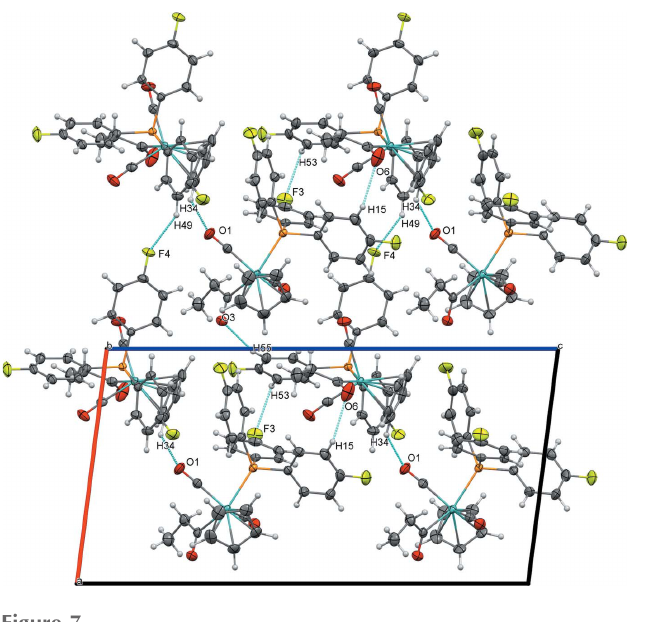
Figure 6 Chains along [001] of the two nearly identical molecules of ( 2 ) in the asymmetric unit, with their C—H (cid:2)(cid:2)(cid:2) O and C—H (cid:2)(cid:2)(cid:2) F interactions, viewed along [010].